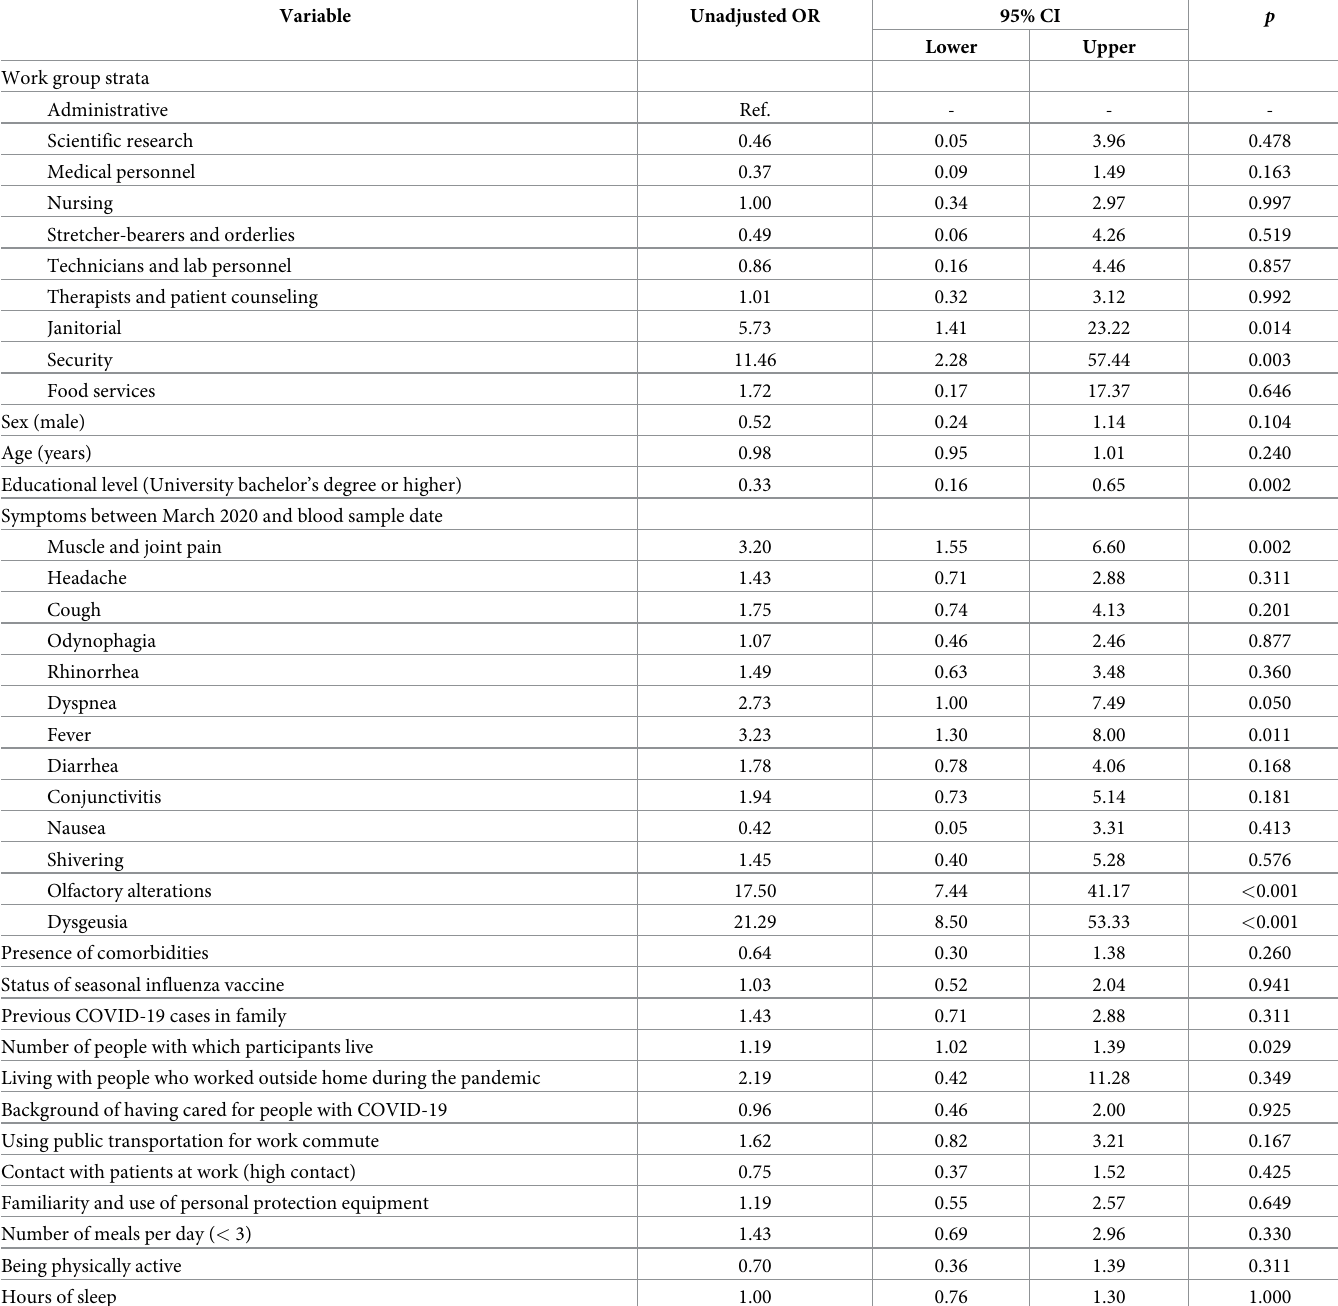
Table 2. Logistic regression analysis of associations between variables and ELISA test results.